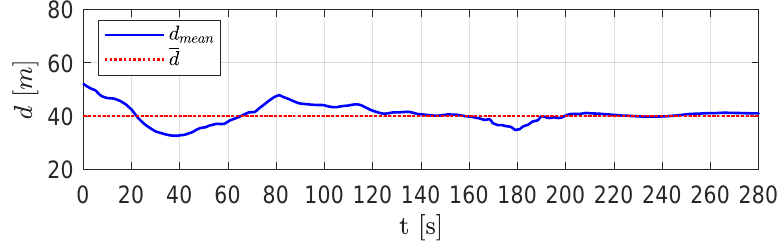
Figure 29. Scenario #3—10 aircraft: mean distance between visible aircraft (blue solid line) compared with desired distance (red dotted